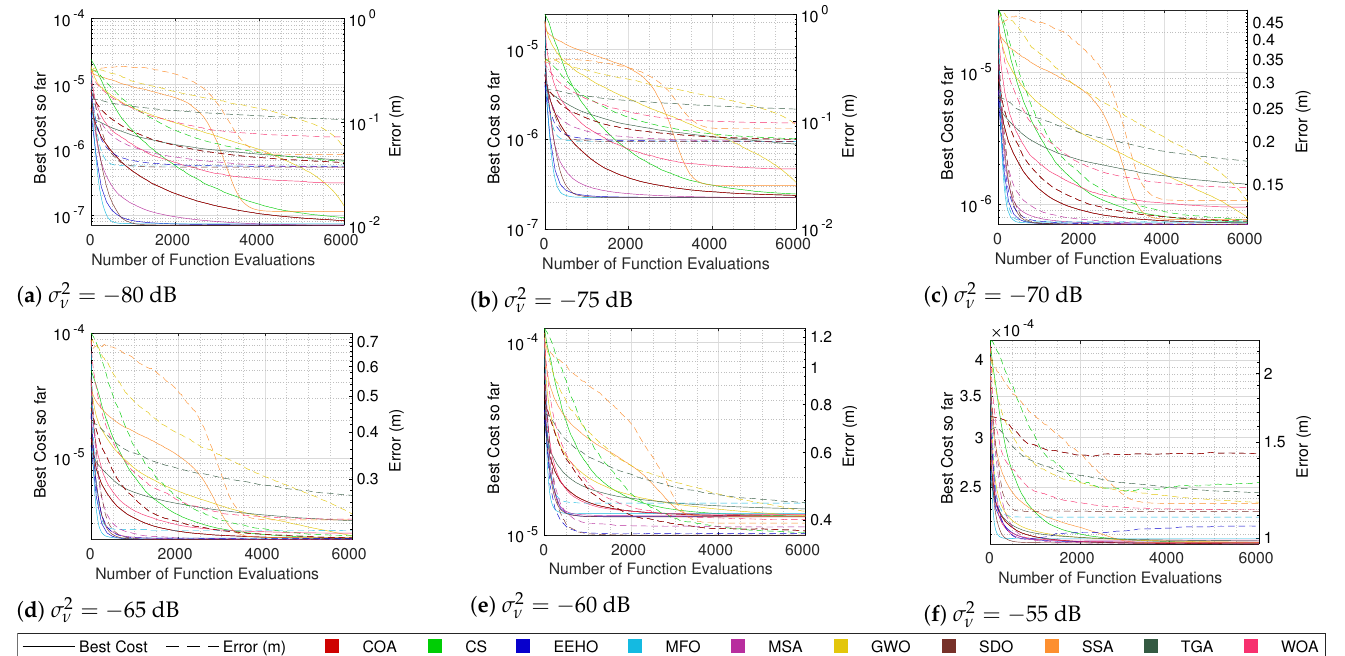
Figure 4. Cost convergence and respective error for each algorithm when N =